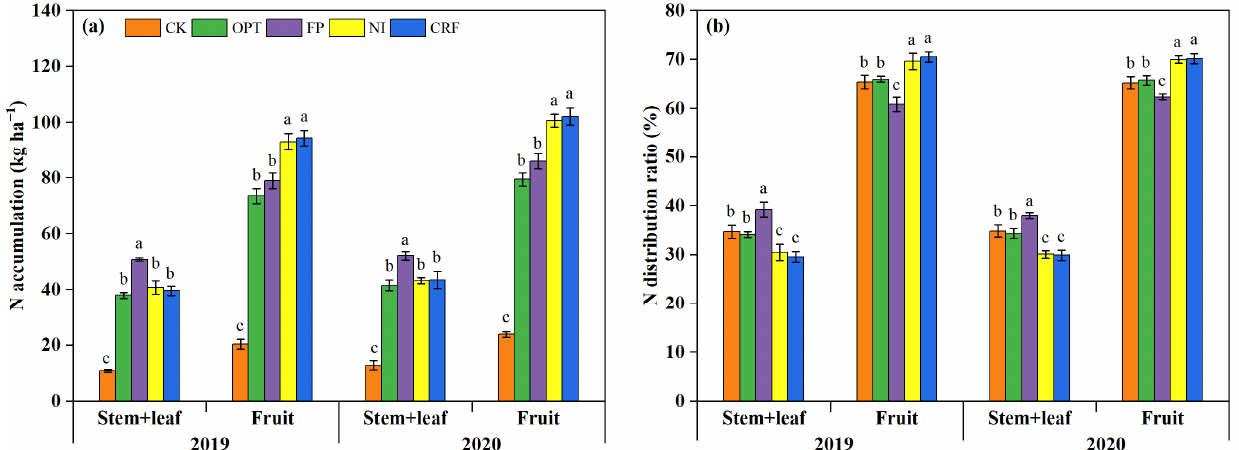
Figure 6. Amount ( a ) and distribution ratio ( b ) of N allocated to the vegetative organs (stem + leaf) and fruit in the harvest period in 2019 and 2020. Different lowercase letters indicate the statistical significance at the p = 0.05 level. The vertical bars represent the standard error ( n = 4).